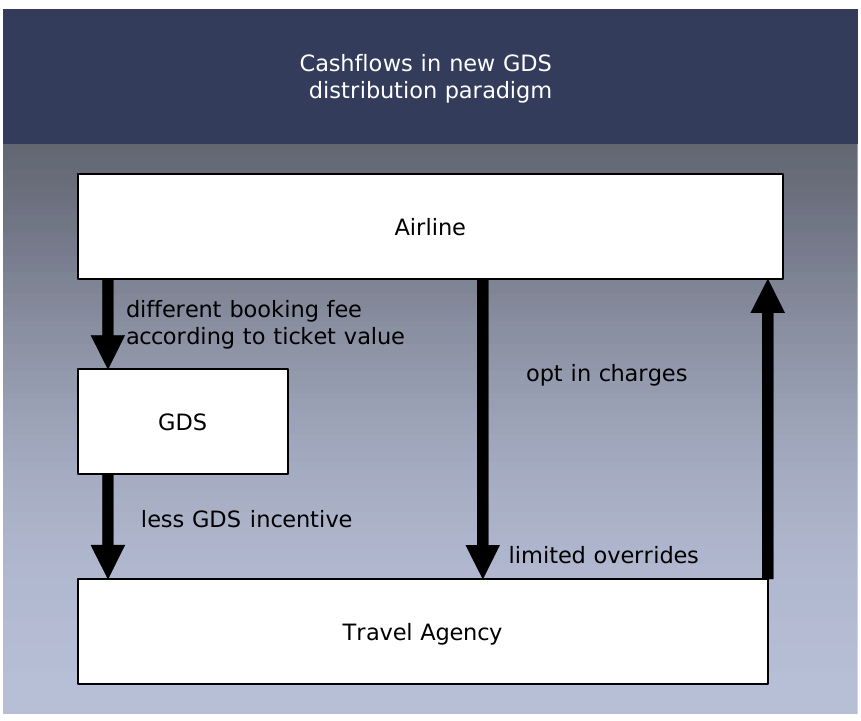
Figure 2. “Changing GDS model”. Source: